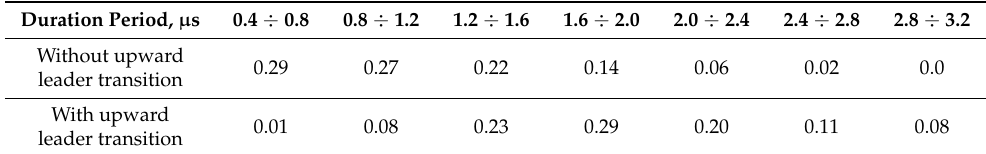
Table 3. The relative frequency of the duration of the period T 0.5 when a current of more than 50% of the maximum value flows through the stem,